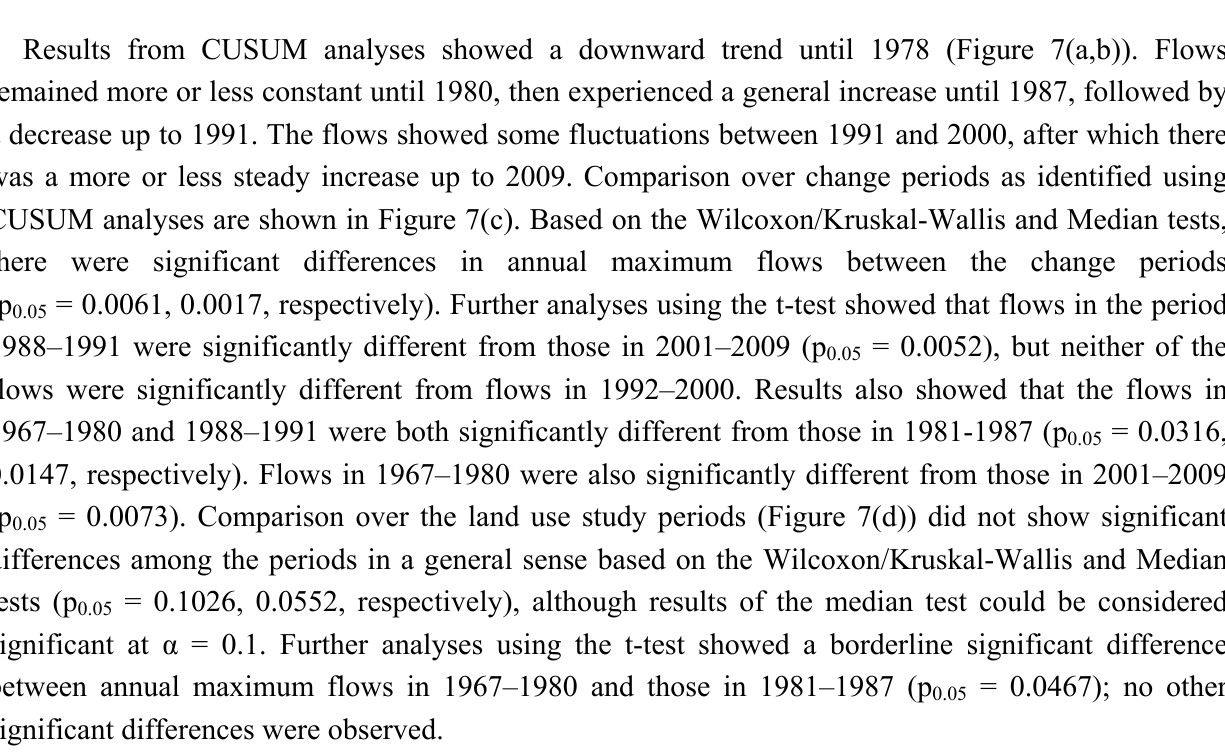
Figure 7. Results of analyses to detect points of change in annual maximum time series at S-79. ( a ) Comparison to long-term median. ( b ) CUSUM values. ( c ) Comparison of flows during various periods identified in (b). ( d ) Comparison of flows during the land use study